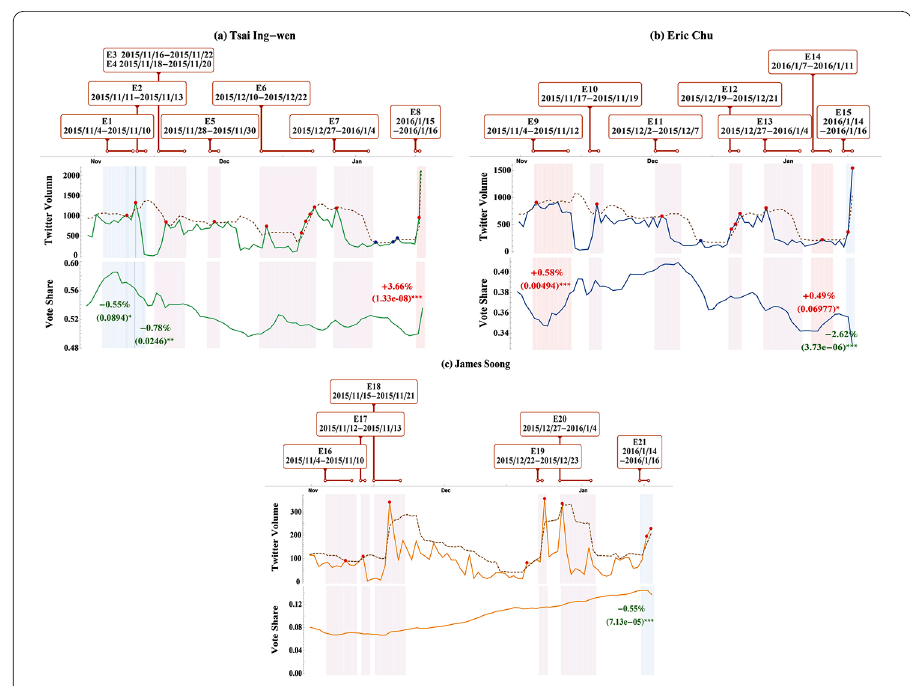
Figure 5 Detected events and their influence on potential vote shares. The numbers of detected events during the elections are 8, 7, and 6, respectively, for the Tsai, Chu, and Soong. The description of events E i is presented in Table 1. Each event spans a time window and influences the potential voting rates differently, as denoted by different colors. A light purple bar indicates that the detected event does not have a significant influence on the vote shares. A red bar indicates a positive effect of the event on vote shares, and a blue bar represents a negative effect of the event. The influence of each significant event is marked on the curve, and the number below it in brackets is the p -value of the t-test. The typical words used to determine the event timespan are detailed in Additional file 1, Table S9, Table S10, and Table S11. In addition, the Twitter bursty days detected in Step I are noted in the Twitter volume time series. The red points represent events with a timespan longer than one day, which are fed into Step II for further analysis. The blue points are